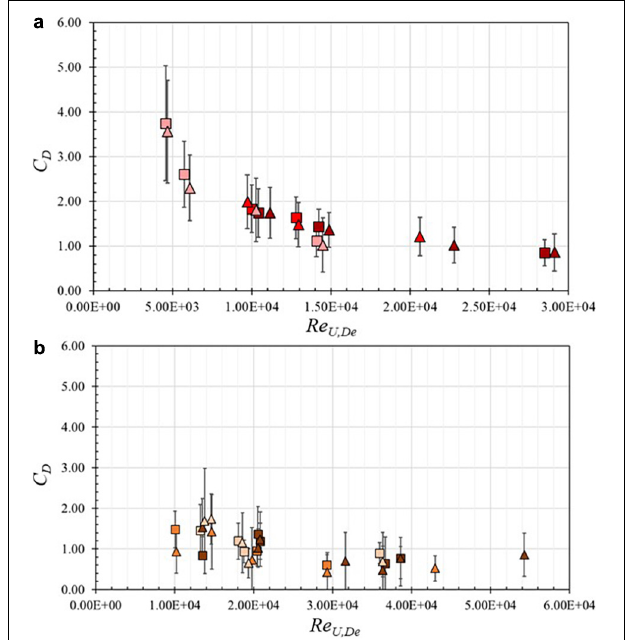
FIGURE 9 | Drag coefficient, C D , versus the Reynolds number, Re U , De on a linear scale for high-density (squares) and low-density (triangles) configurations designated by relative water depth. (a) Random wave cases, 0.30 < k p h v < 0.40 (dark red), 0.70 < k p h v < 0.80 (intermediate red), and 1.30 < k p h v < 1.45 (light red). (b) Regular wave cases, 0.30 < kh v < 0.45 (dark orange), 0.45 < kh v < 0.80 (intermediate orange), and 1.10 < kh v < 1.40 (light orange). Vertical bars show combined uncertainty due to A t and e α m . Note change in x- axis scale from (a) to (b)